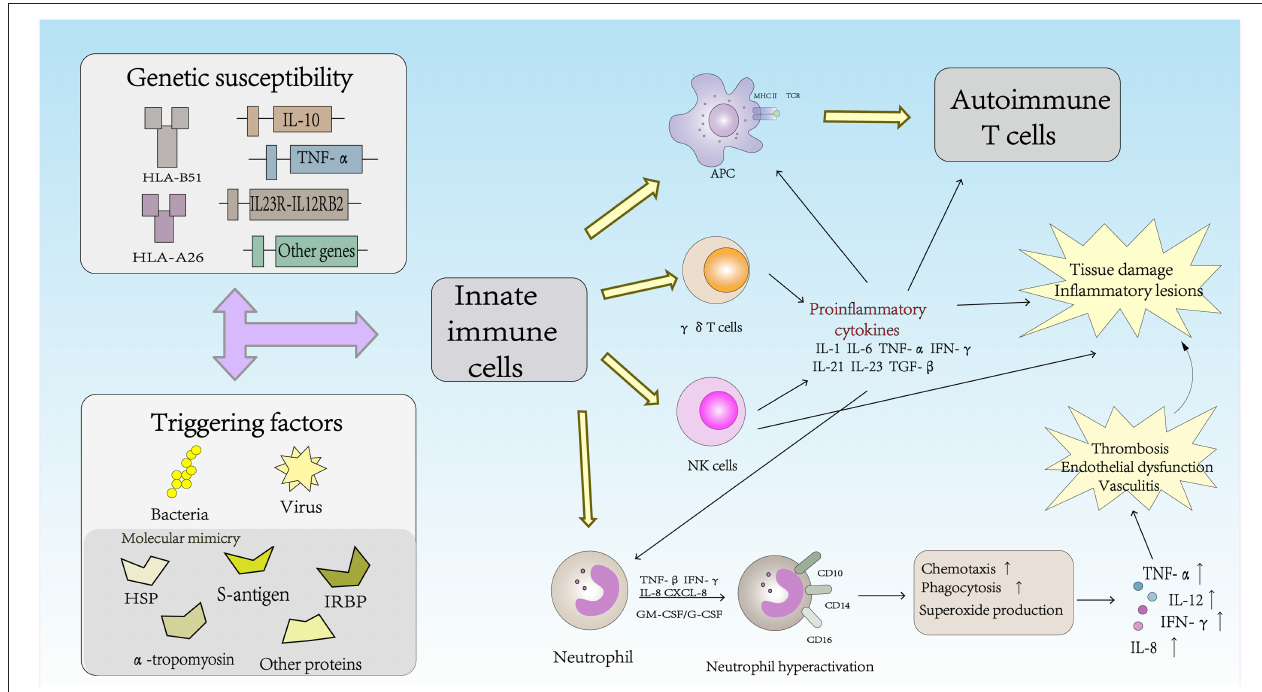
FIGURE 1 | The role of innate immune cells in the pathogenesis of Behcet’s disease.